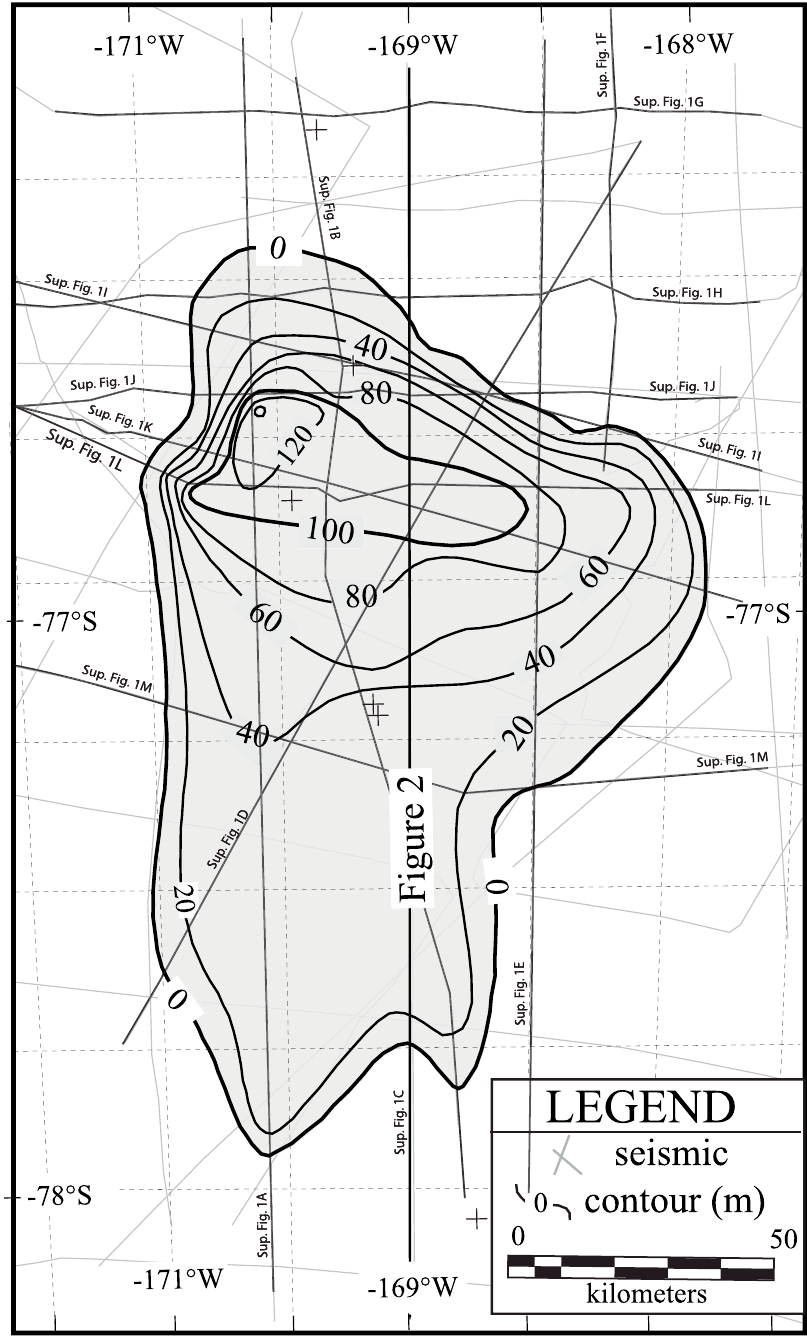
Figure 3. Isopach map of the composite GZW in meters. The contour interval is 10 m. The light-shaded rectilinear grid shows the location of seismic profiles used to map the distribution of the